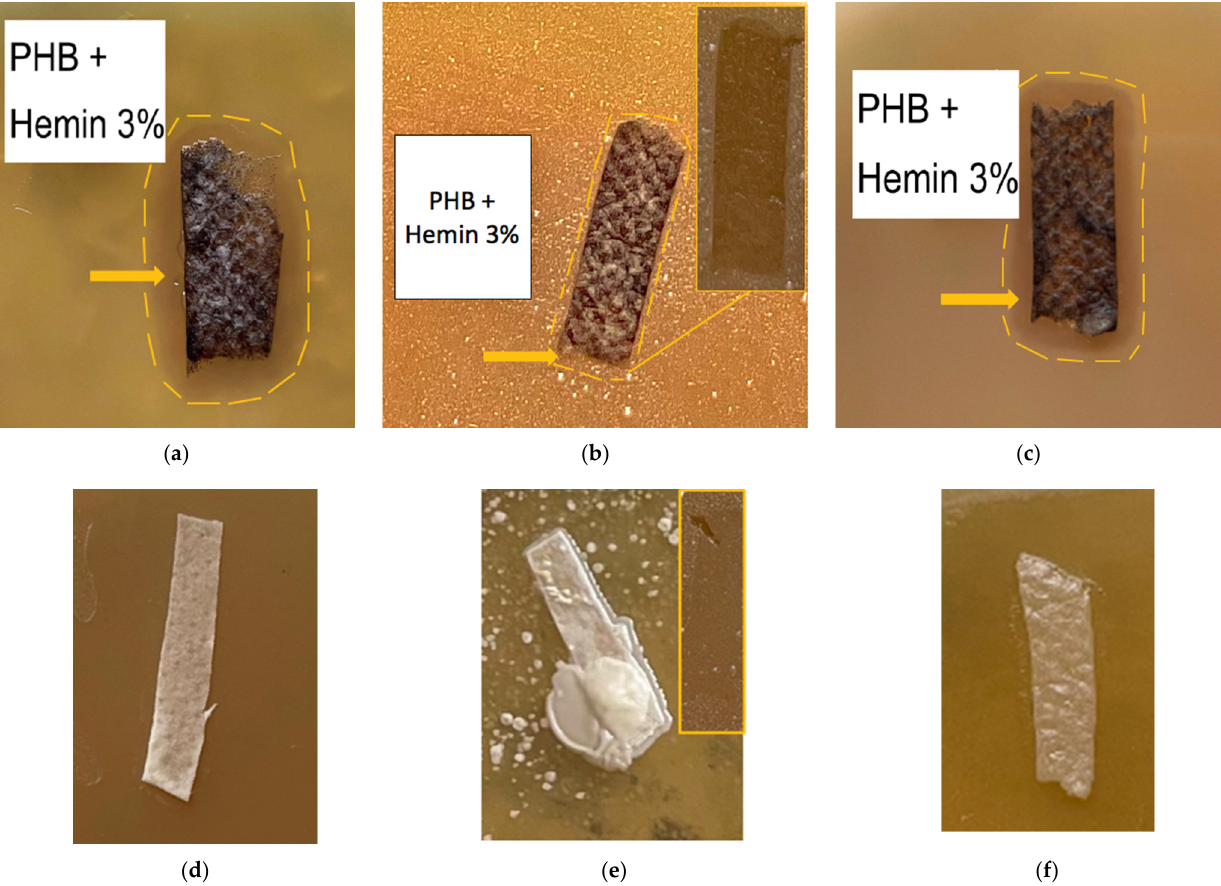
Figure 9. The microbiological tests of the PHB + 3% of the hemin samples against ( a ) E. coli ; ( b ) C. guilliermondii ( c ) S. aureus ; the lysis zone is shown in colored line and PHB + 0% against ( d ) E. coli ; ( e ) C. guilliermondii ; and ( f ) S. aureus as the control.